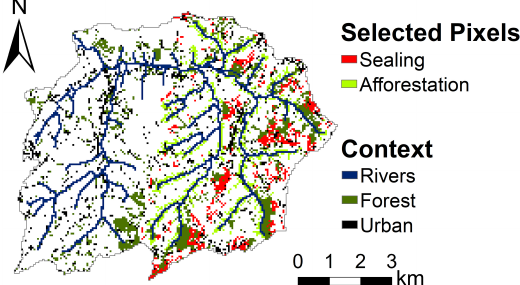
Figure 5. Locations of the pixels selected for land use change im- plementation, i.e., the 750 priority pixels (187.5ha), for both the afforestation and soil-sealing scenarios.